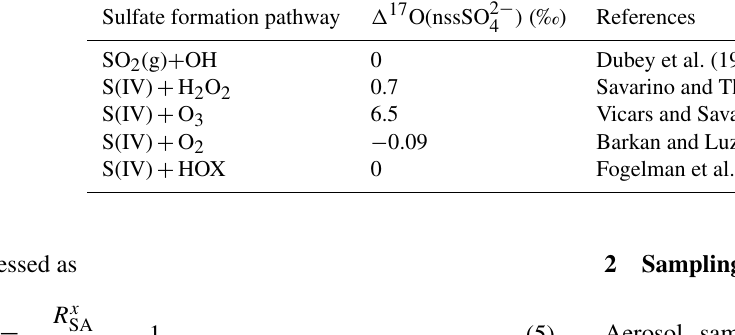
Table 1. (cid:49) 17 O of sulfate produced via different pathways. Sulfate formation